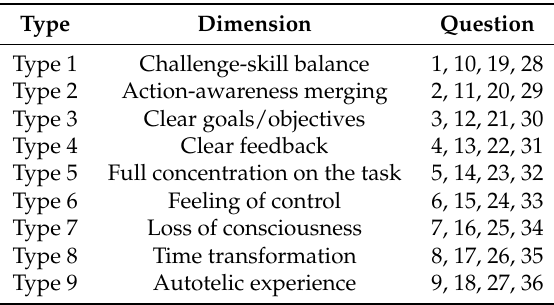
Table 7. Flow Dimensions and FSS Questions